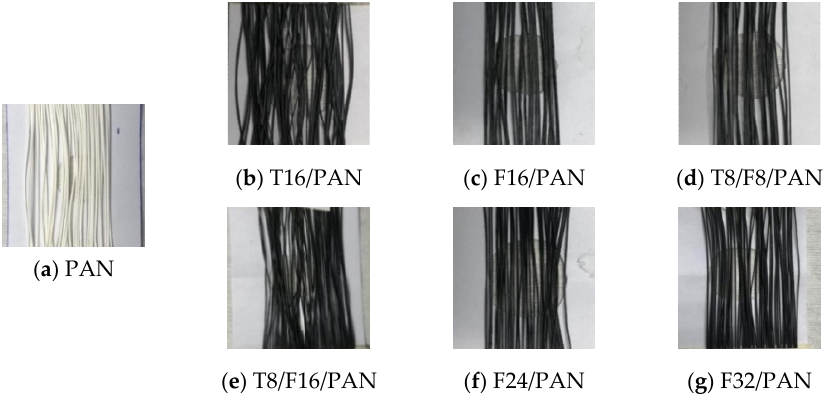
Figure 2. Obtained PAN-based conductive yarn through wet spinning. ( a ) PAN, ( b ) T16/PAN, ( c ) F16/PAN, ( d ) T8/F8/PAN, ( e ) T8/F16/PAN, ( f ) F24/PAN, ( g ) F32/PAN.